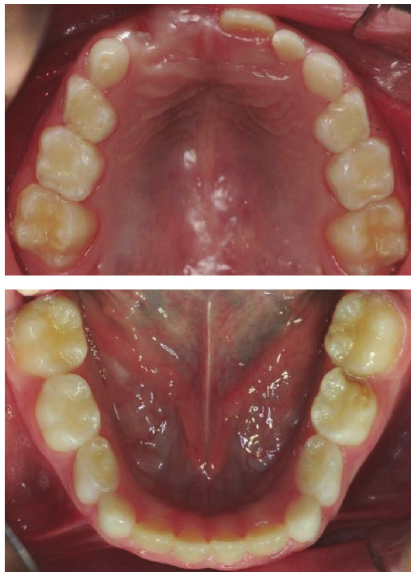
Figure 3: Maxillary and mandibular occlusal views. Note the pres- ence of a dental caries lesion developed on the hypomineralized distal-occlusal surface of tooth #75. There is no evidence of clinical alterations in the right mandibular teeth and mucosa.